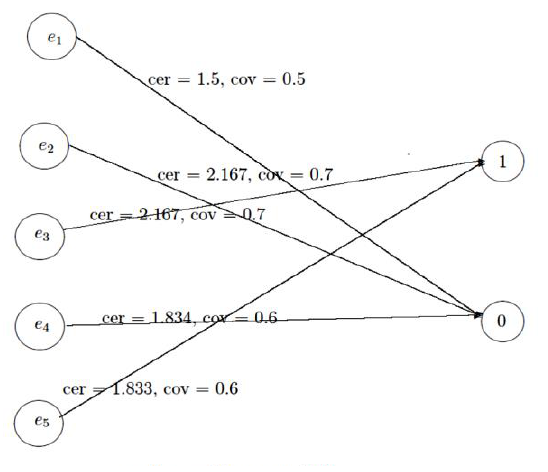
Fig. 2. Approximate